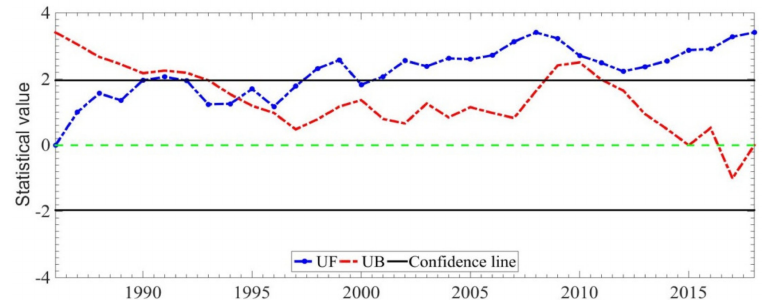
Figure 7. The trend of annual average air temperature at the Ugii Nuur Lake site (where UF and UB are parameters of the change, UB = − UF).